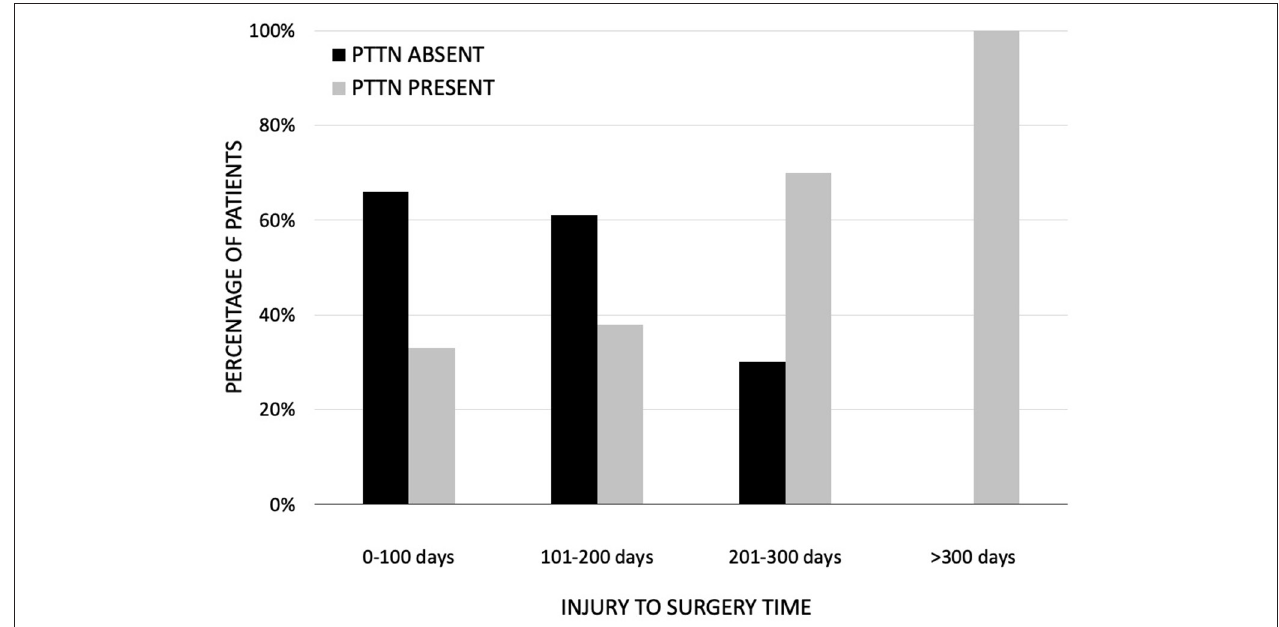
FIGURE 2 | Absence and presence of neuropathic pain at 6 months postsurgical follow up. When the time to surgery was 200 days or less, the percentage of patients with neuropathic pain before surgery with no neuropathic pain at the 6 month follow up was greater than 60%.